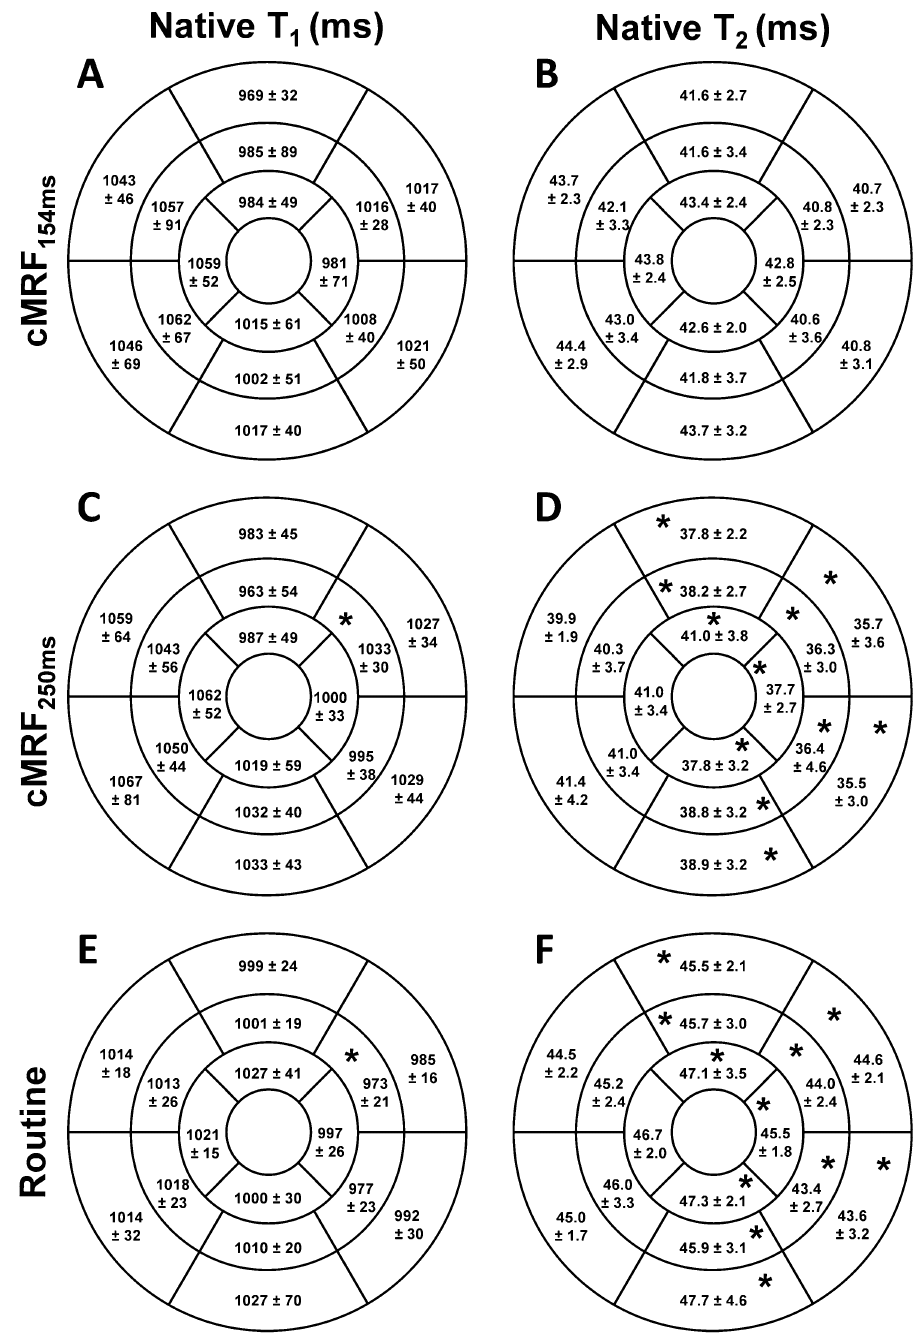
Figure 2. Circumferential polar plots of the myocardial relaxation times in 9 healthy volunteers. Myocardial areas were segmented according to the AHA guidelines 29 . Each segment reports the average relaxation time and its standard deviation across all volunteers in milliseconds. cMRF with a shorter acquisition window is shown in the first row ( A and B ); cMRF with a longer acquisition window is shown in the second row ( B and C ) routine T 1 and T 2 values are reported in the third row ( E and F, respectively). No significant differences were found between the two variations of cMRF as well as between cMRF with a short acquisition window and routine techniques. Significant differences were found exclusively in the mid and apical slices between routine and cMRF with a longer acquisition window, as highlighted (*P <